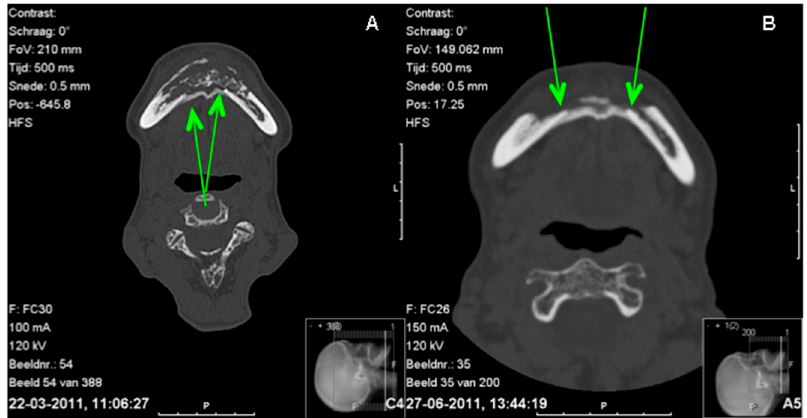
Figure 3. Comparison CT scans before ( A ) and three months after surgery ( B ). A = lingual subperiosteal bone can be seen and seems to connect both parts of the mandible; B = the difference between the cortex of the mandible and the subperiosteal bone is decreasing.